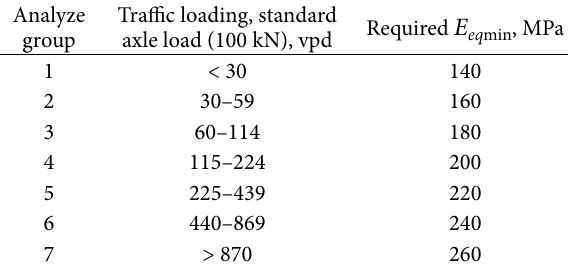
Table 2. Analyze groups, traffic loadings and required E eq min (Metsvahi et al. 2005) Analyze group